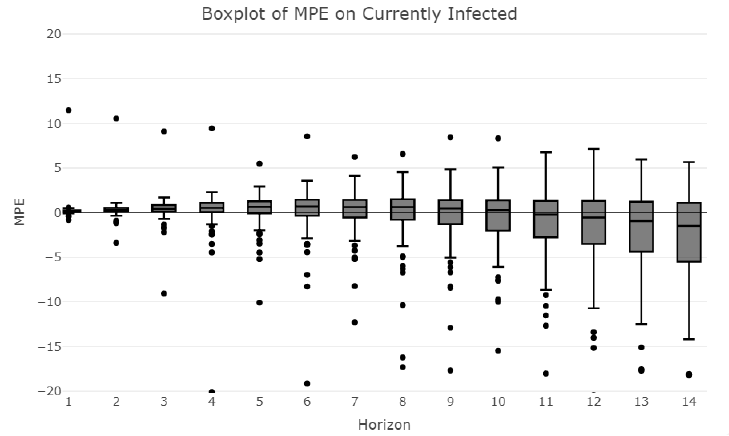
Figure 6. Boxplots of MPE on currently infected.